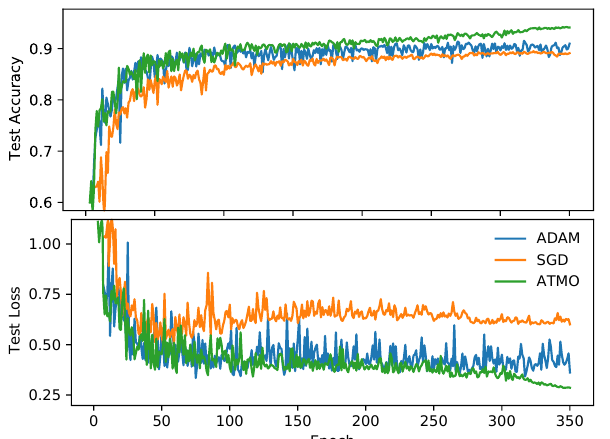
Figure 4. Resnet18 test accuracies with the best parameters of the best results obtained on